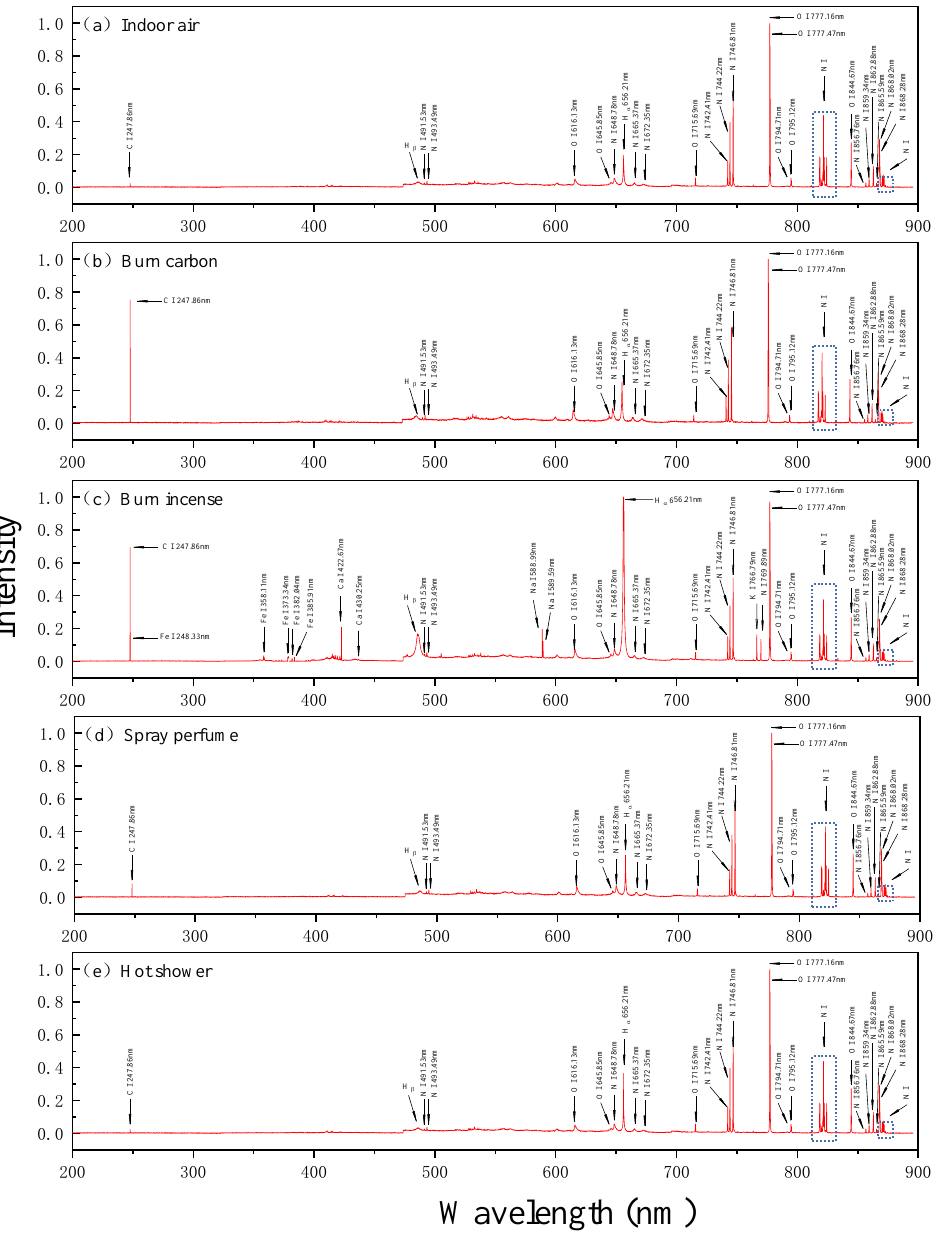
Figure 2. ( a ) Spectra (200 nm to 890 nm) of indoor air; ( b ) Spectra (200 nm to 890 nm) of burning carbon; ( c ) Spectra (200 nm to 890 nm) of burning incense; ( d ) Spectra (200 nm to 890 nm) of spraying perfume; ( e ) Spectra (200 nm to 890 nm) of hot shower.